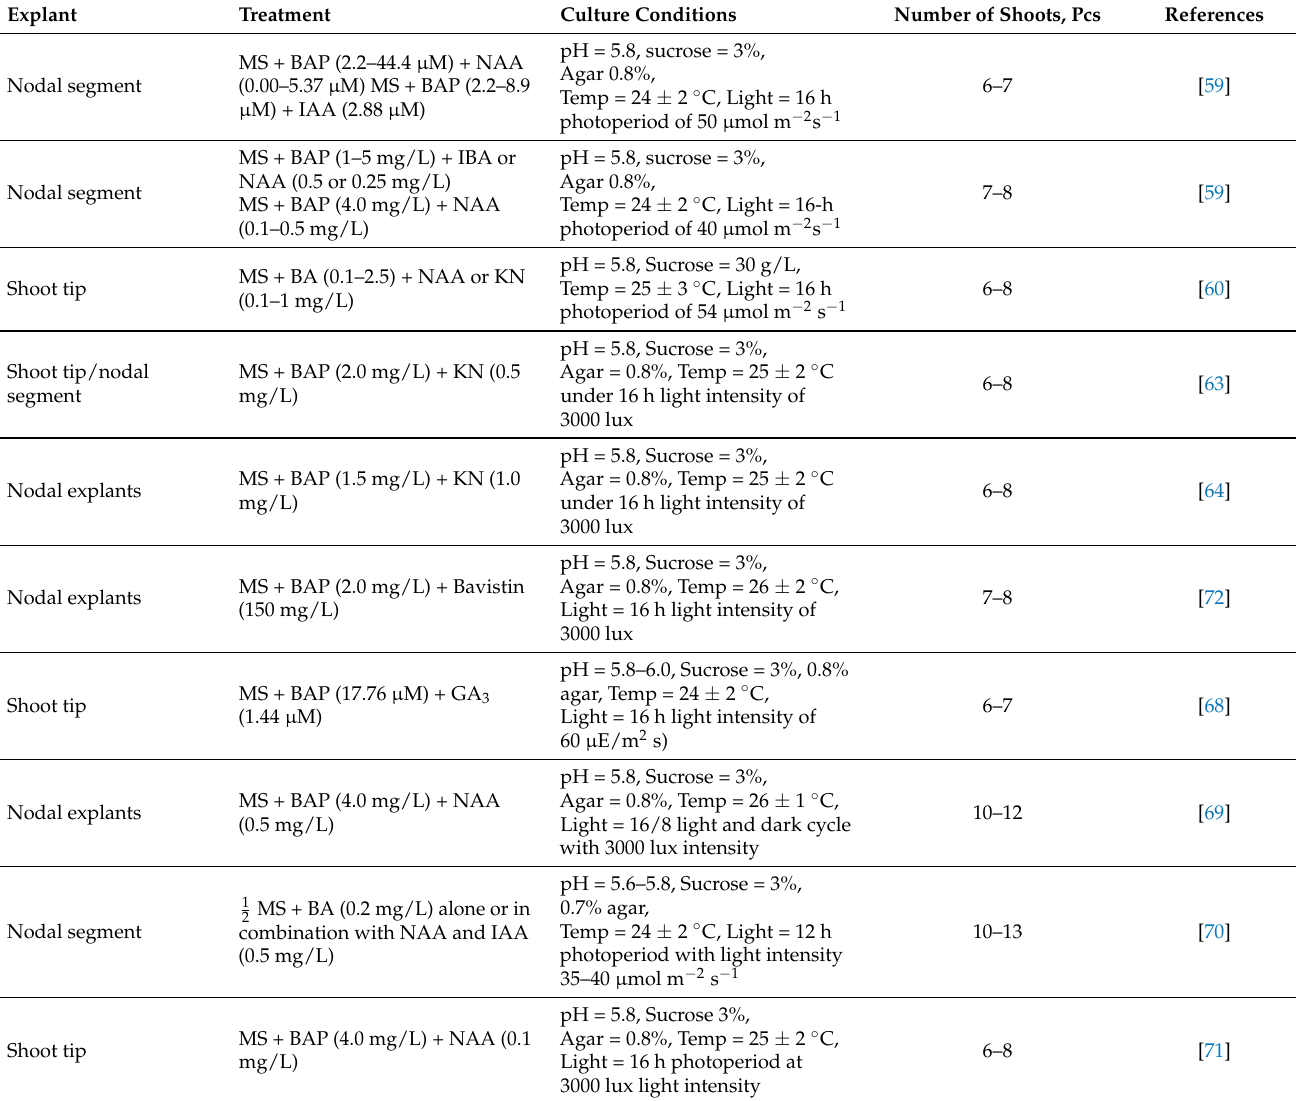
Table 4. Direct organogenesis in C. asciatica